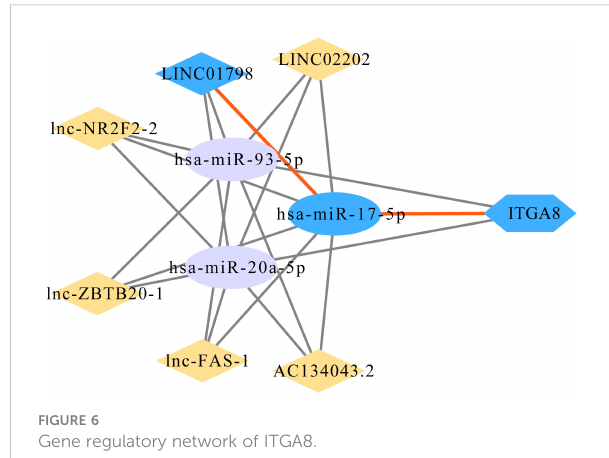
FIGURE 6 Gene regulatory network of